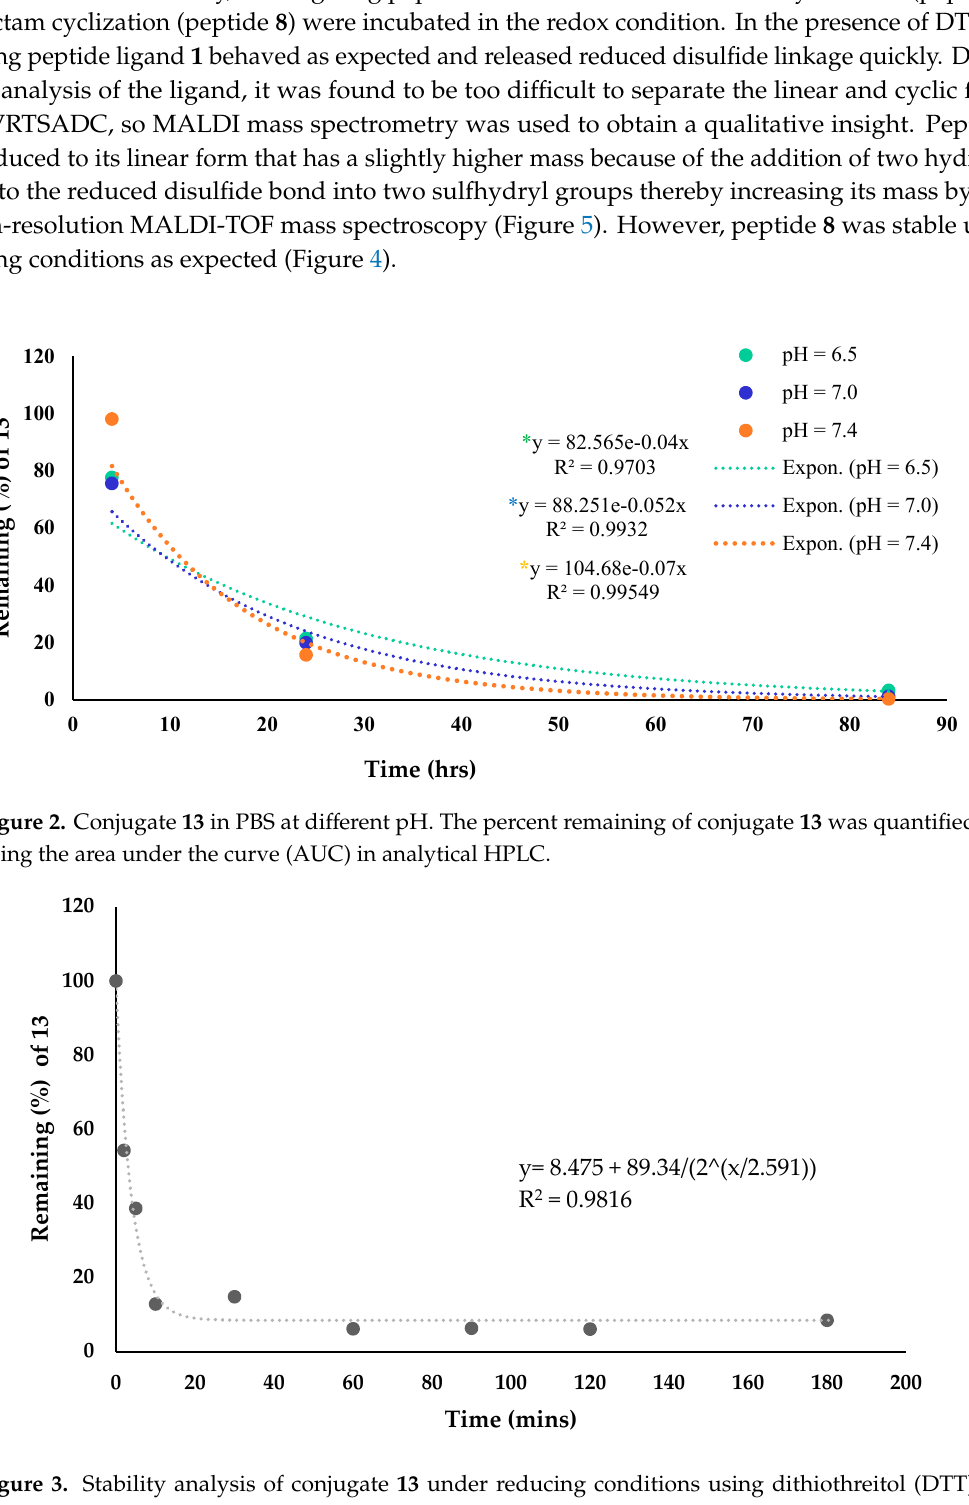
Figure 3. Stability analysis of conjugate 13 under reducing conditions using dithiothreitol (DTT). The experiment was done in PBS at pH 7.4. The percent remaining was quantified using the AUC, and the trendline equation gives the half-life of 2.6 min with an R 2 of 0.98. Fitting was done online using MyCurveFit.